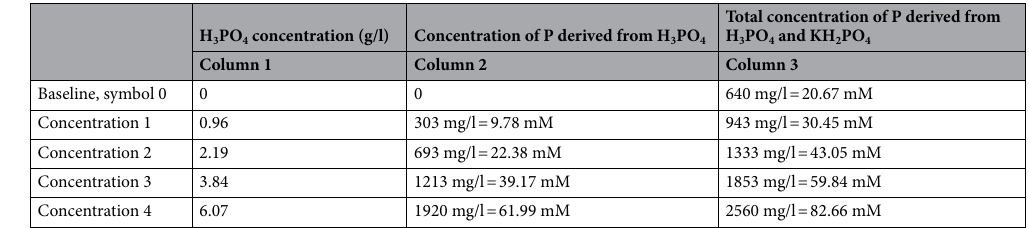
Table 2. Tested H 3 PO 4 concentrations equivalent to the corresponding P